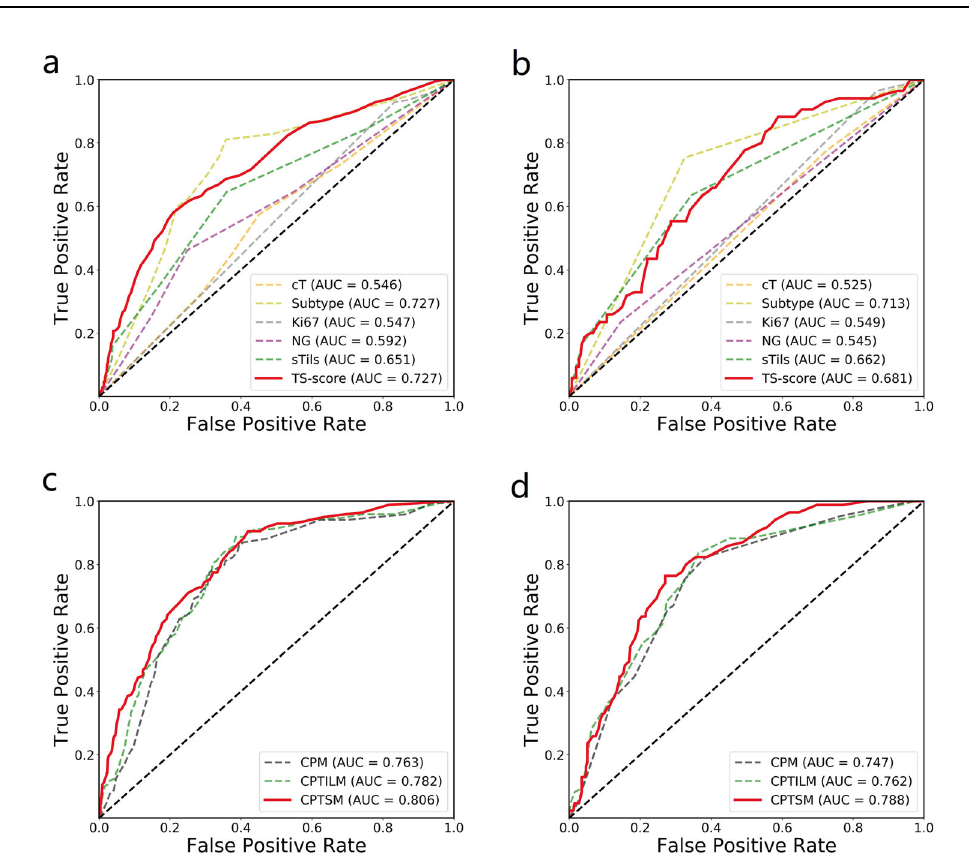
Fig. 4 ROC curves of the marker-based models. The top row shows the performance of the single marker-based models for predicting pCR in the primary cohort ( a ) and the three external validations ( b ). The bottom row shows the performance of the baseline marker-based model (CPM), the baseline marker and sTILs-based model (CPTILM), and the baseline marker and TS-score-based model (CPTSM) for predicting pCR in three three external validations ( c , d